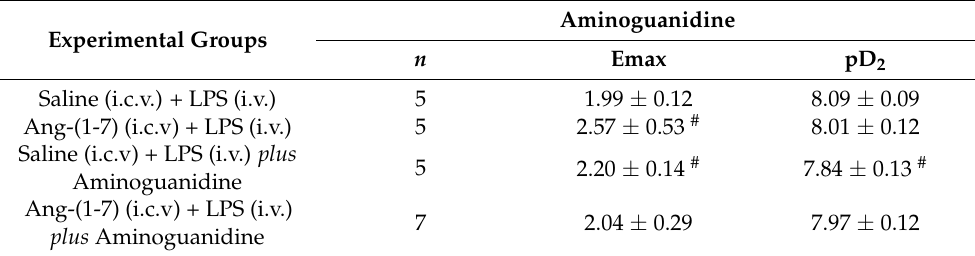
Table 3. Values of Emax and pD 2 obtained from concentration-response curves in response to NE, in the presence or absence of aminoguanidine (in vitro), in thoracic aorta rings of endotoxemic rats treated or not with Ang-(1-7).